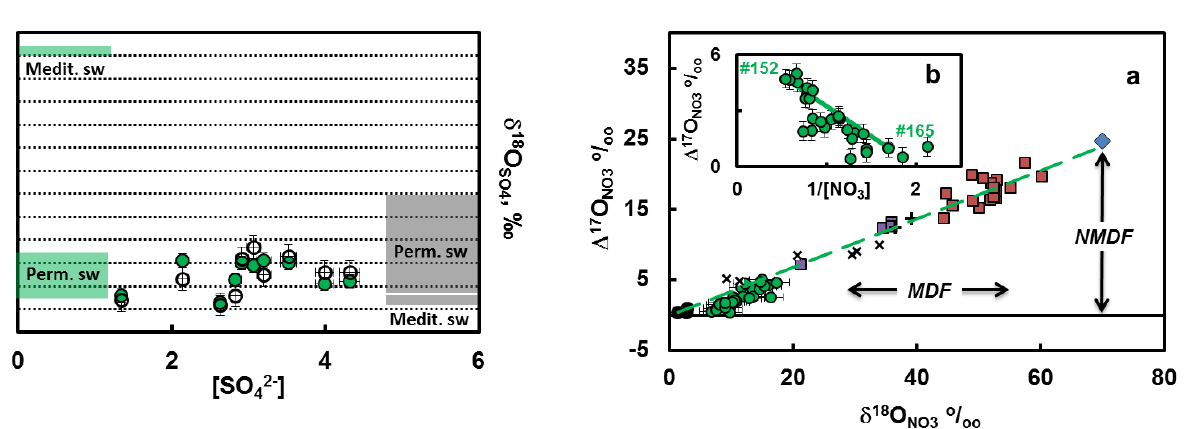
 18 O NO3 and  15 N NO3 values are referred to the VSMOW and AIR standards,